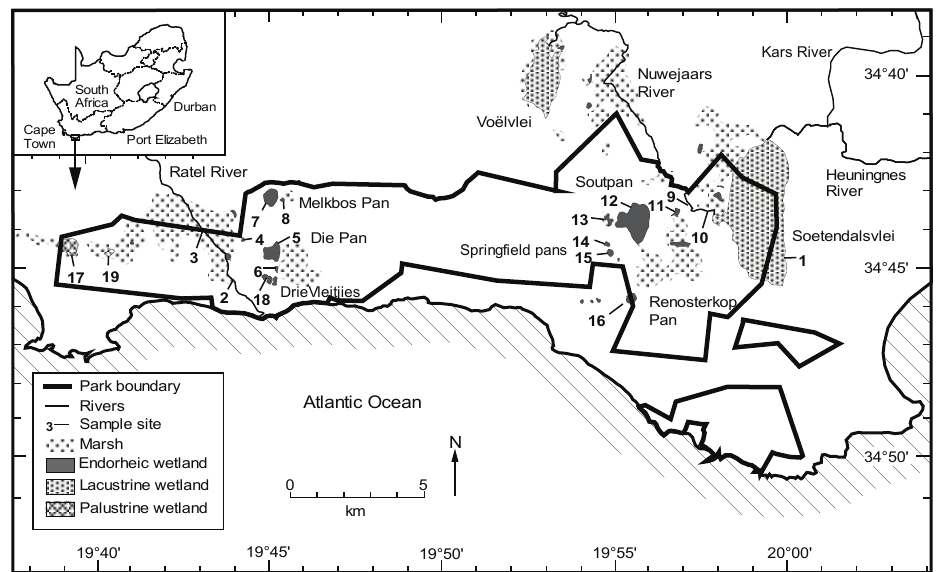
Fig. 1. Map of the Agulhas National Park indicating sites used to sample fish